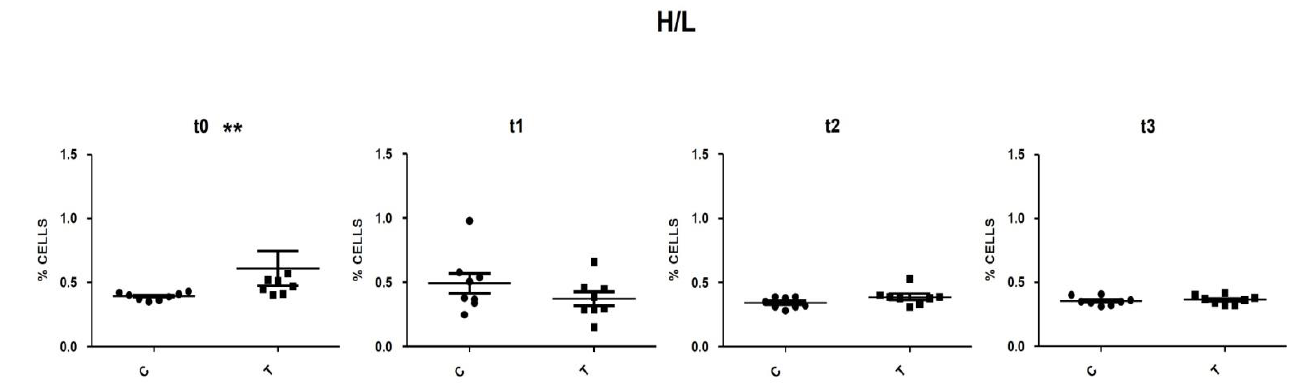
Figure 3. Results of gating strategy in Flow Cytometry analysis. ( A ) Representative cytogram (FSC-A versus SSC-A): debris is located at the lower-left corner of the cytogram, nucleated erythrocytes appear as a smear on the left, in the lower-right area lymphocytes and thrombocytes are placed, in the upper-right area heterophils are contained. ( B ) FSC-A/FSC-H plot for doublets exclusion: singlets have a proportion between area and height values while doublets have double the area values of single cells whilst the height is the same. ( C ) Singlets were analysed for CD45-APC fluorescence intensity. In the area with the highest APC fluorescence, two populations can be identified: a population with low SSC values (yellow) and a population with higher SSC values (pink) ( D ) CD45-positive cells cytogram in which lymphocytes and heterophils areas are selected.